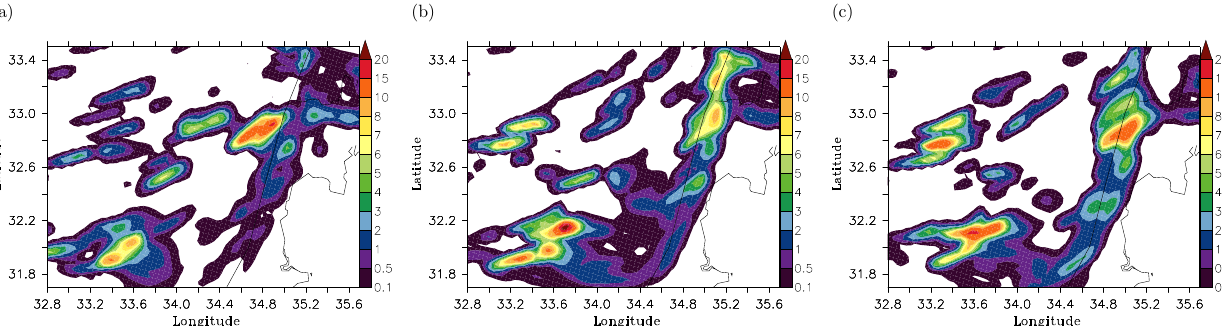
Fig. 4. Simulated accumulated precipitation between 02:00 and 03:00UTC at 29 January 2003 for the 4km domain for the following scenarios: (a) NOdust (b) τ 1 (c) τ 48